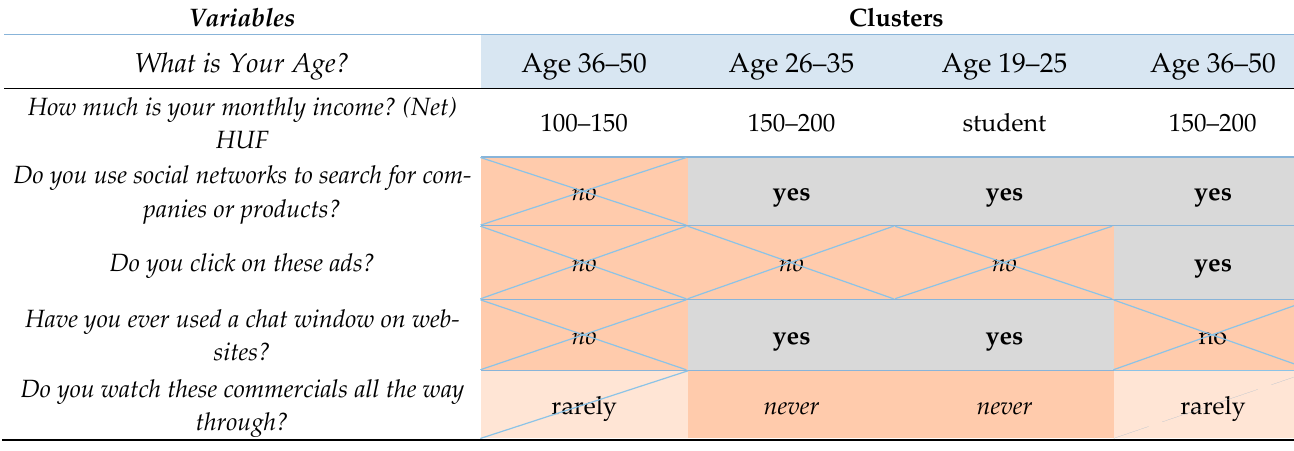
Table 2. Characteristics of clusters.